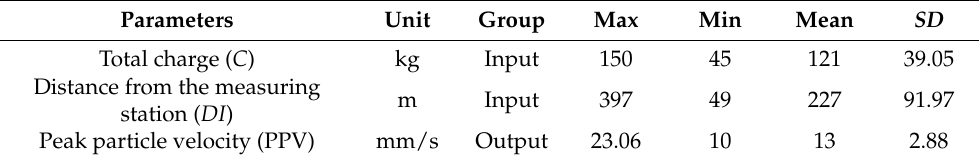
Table 2. Input and output variables and their relevant statistical information. Parameters Unit Group Distance from the